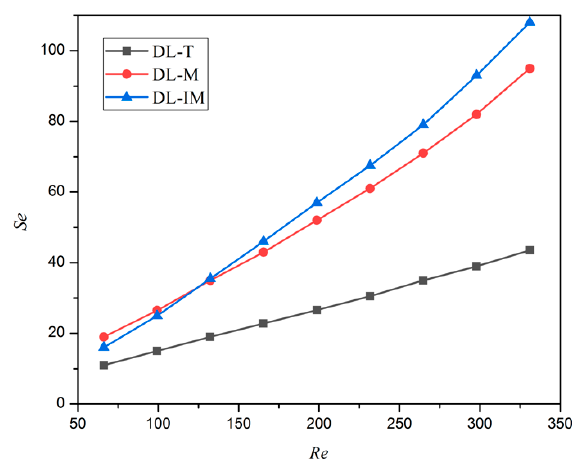
Figure 16. The variation of the secondary flow intensity vs. the Reynolds number.